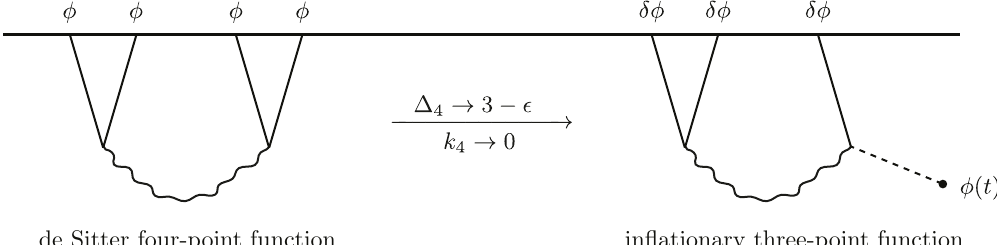
Figure 9. In(cid:13)ationary three-point functions can be derived from de Sitter four-point functions by evaluating one of the legs on the time-dependent